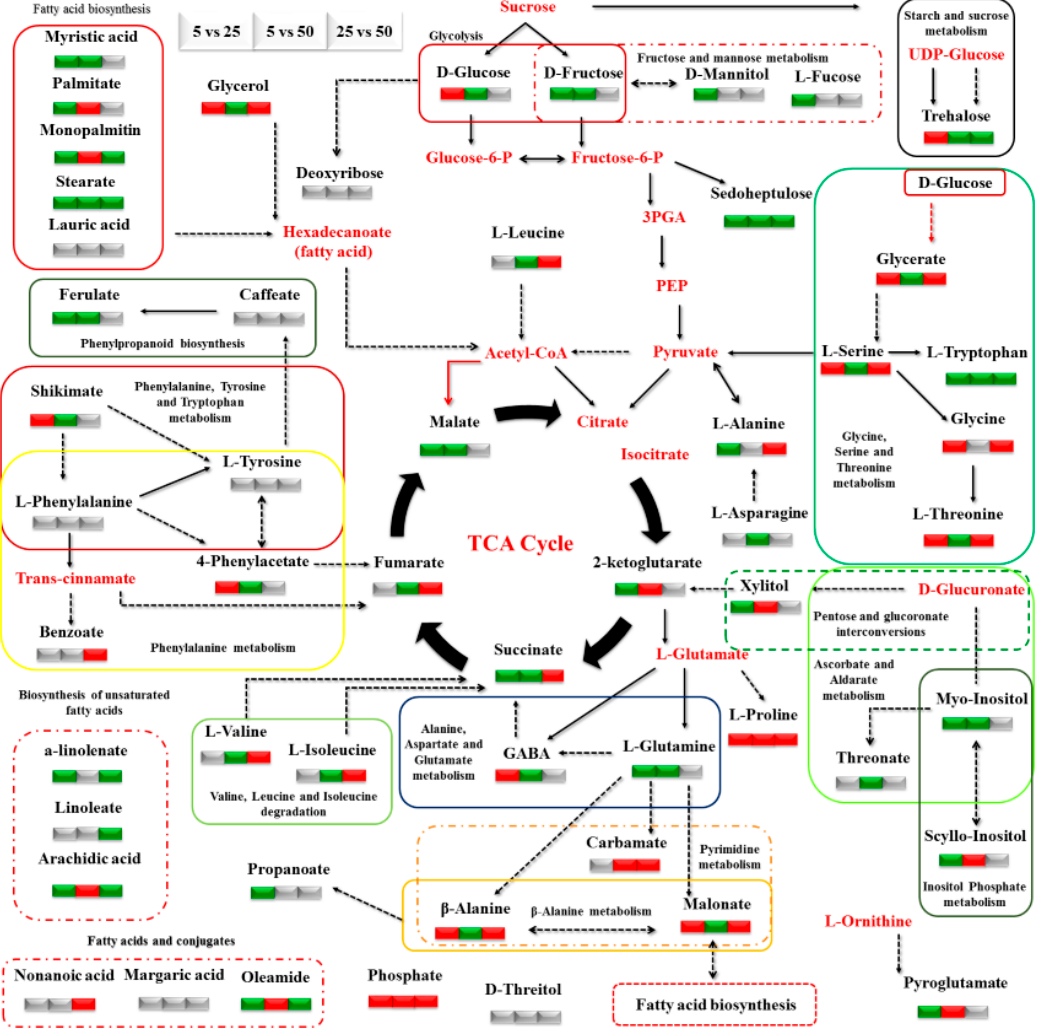
Figure 7. Fluctuation of Cichorium spinosum montane ecotype plants’ metabolite levels followed treatments with three different NH 4+ /total-N ratios. The first block (from left to right) below metabolites corresponds to the comparison between the lowest and the medium NH 4+ /total-N ratios, the middle block to the one between the lowest and the highest NH 4+ /total-N ratios, and the third block to the comparison between the medium and the highest NH 4+ /total-N ratios. The metabolites in bold red font indicate the undetected metabolites. Red color bars correspond to metabolites whose relative composition increased in the montane (M) ecotype, whereas green bars correspond to metabolites that decreased. Gray color corresponds to metabolites whose levels were not substantially altered. Data were retrieved from the KEGG database (http://www.genome.jp/kegg). Solid arrows correspond to subsequent steps of a biosynthetic pathway, whereas dashed arrows correspond to multi-step links.